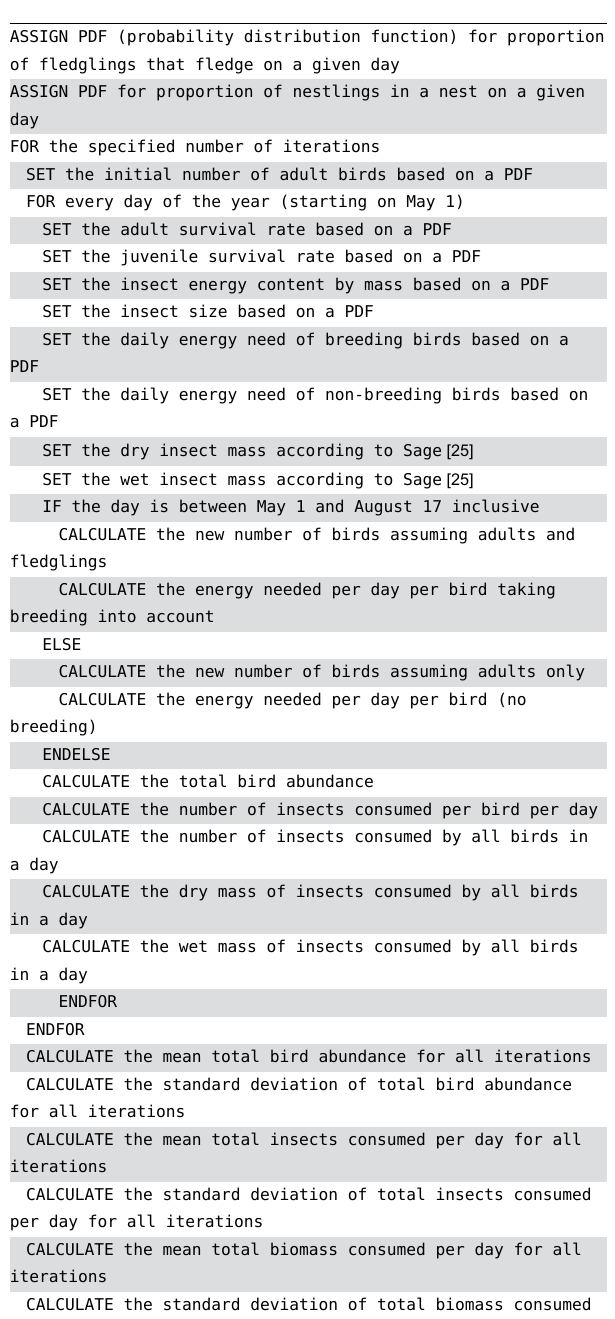
Table 2. Psuedocode describing the logic and structure of the Matlab script used to model abundance and energetics of Purple Martins during one